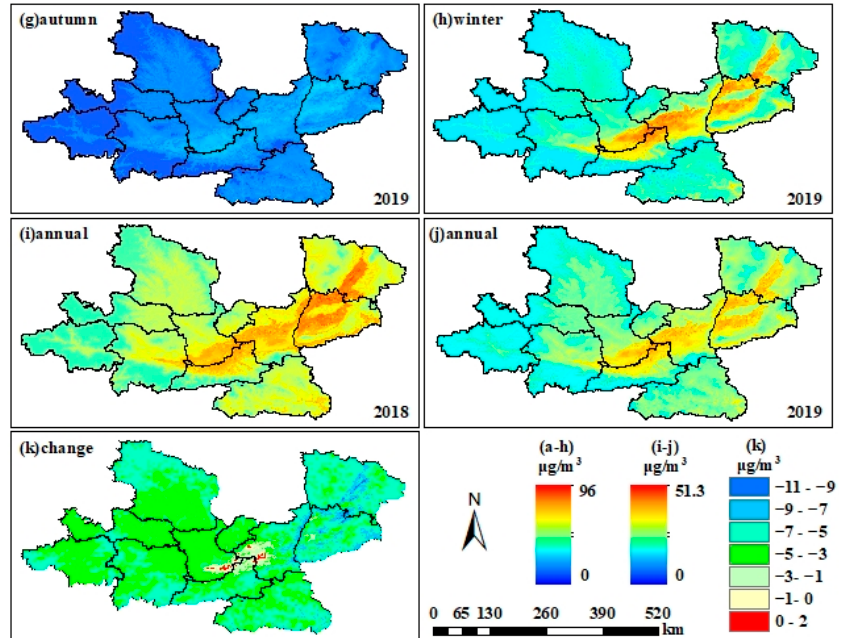
Figure 9. The mean predicted seasonal ( a – h ) and annual ( i – j ) PM 2.5 concentrations distribution based on the XGBoost model and the rate of change of annual PM 2.5 concentrations from 2018 to 2019 ( k ).